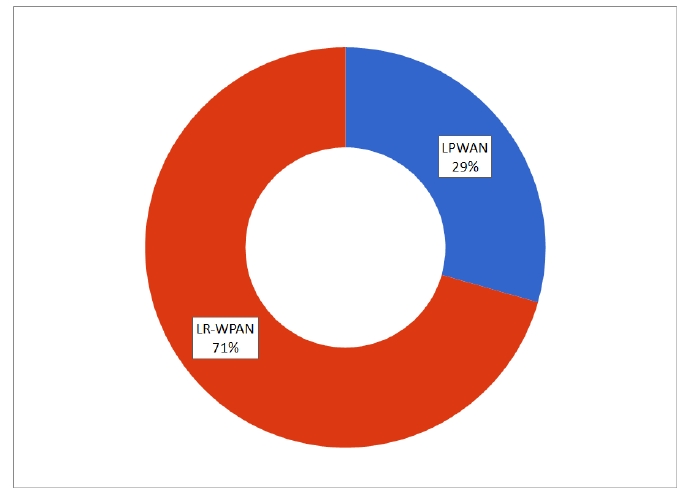
Figure 11. Network design